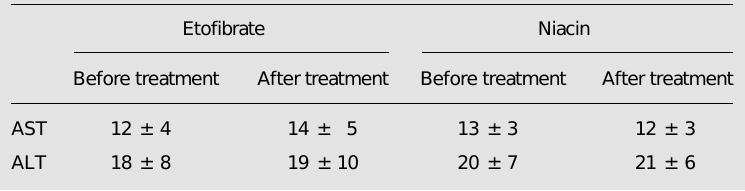
Table 3 - Analysis of liver toxicity after treatment with etofibrate or niacin. P>0.05 for all differences before and after treatment. ALT, Alanine aminotransferase; AST, aspartate